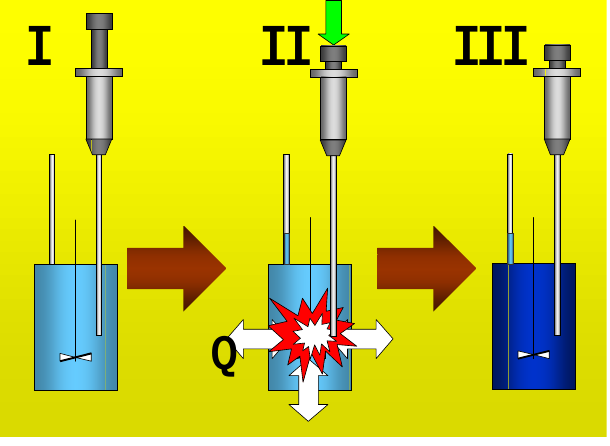
Figure 1. Typical performance of an isothermal titration calorimeter. The electronic details of the measurement of the calorimetric signal have been omitted for